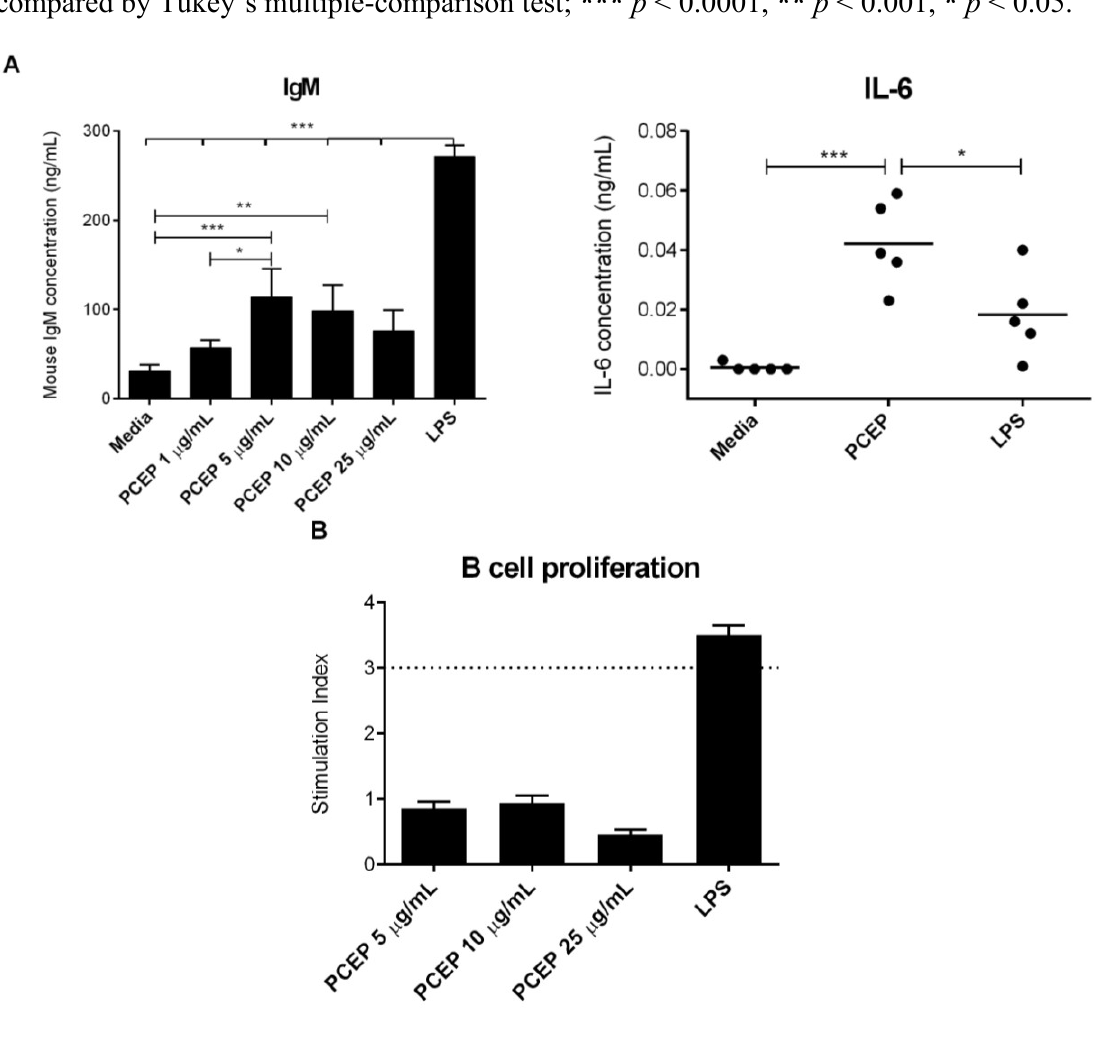
Figure 4. PCEP induces direct activation of naive B-cells in vitro . ( A ) Enriched splenic CD19 + B-cells (2 × 10 6 ) were cultured in the presence of media, PCEP (10 μg/mL) or lipopolysaccharide (LPS) (0.1 μg/mL), and culture supernatants were collected after 48 h for quantification of IL-6 and IgM by ELISA; ( B ) enriched naive B-cells (2 × 10 5 cells/well) were co-cultured with irradiated splenocytes in the presence of medium, PCEP (5 μg/mL, 10 μg/mL and 25 μg/mL) and LPS (0.1 μg/mL) for five days. PCEP-specific B-cell proliferative responses were measured by 3H-thymidine incorporation. Results are expressed as stimulation indexes (counts per minute (cpm) in the stimulated cultures/cpm in the controls). Tests were carried out in triplicate. A stimulation index of ≥3 was considered positive for proliferative responses (above dashed lines). All of the ELISA data were statistically analyzed by one-way ANOVA, and the differences between the treatments were compared by Tukey’s multiple-comparison test; *** p < 0.0001, ** p < 0.001, * p <